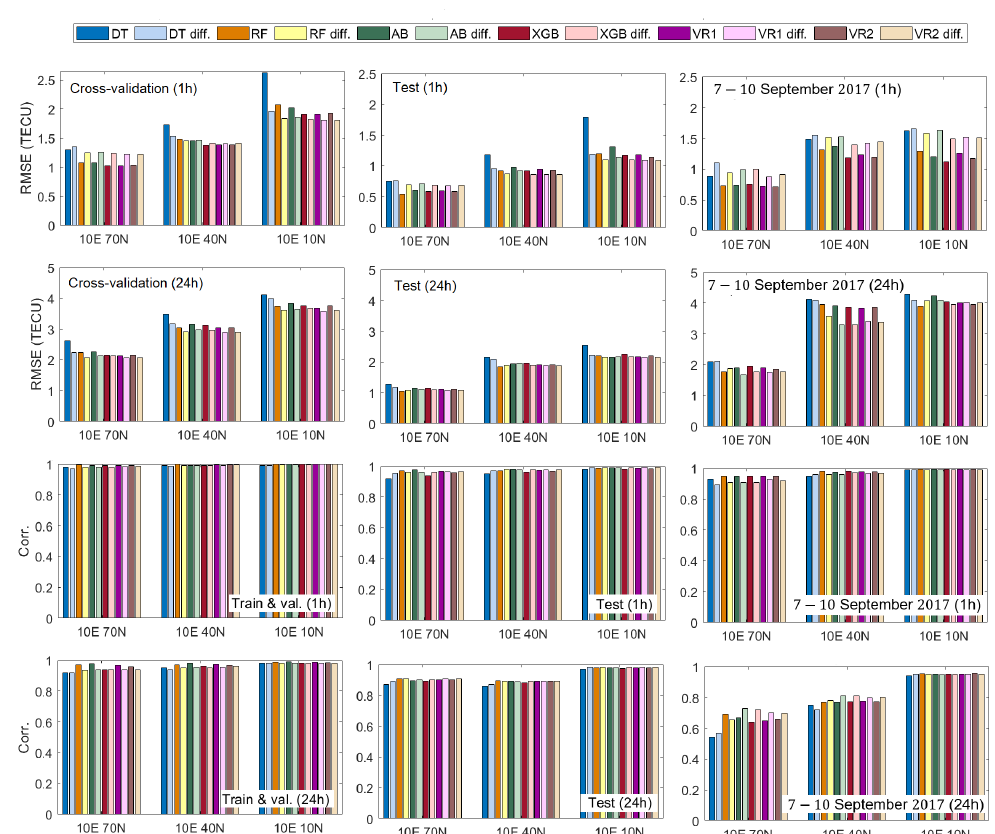
Figure 12. The RMSE and correlation coefficient (Corr.) for cross-validation ( first column ), test ( second column ) and geomagnetic storm (7–10 September 2017) ( third column ) datasets, for 1 h and 24 h forecast horizons for Decision tree (DT), Random forest (RF), Adaboost (AB), XGBoost (XGB) and two Voting regressor models (VR1 and VR2). Models trained of differenced data are marked with “diff” The evaluation on the test dataset is a measure of the models’ generalization to new